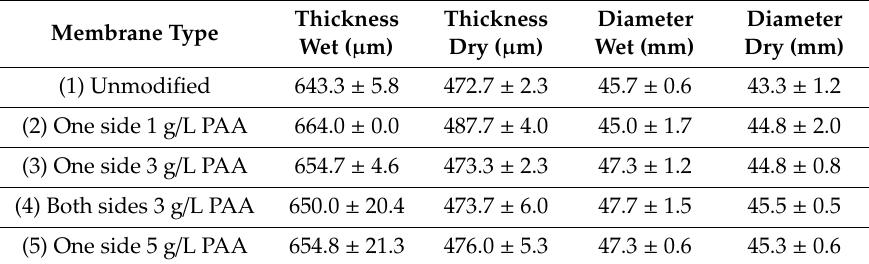
Table 3. Swelling study